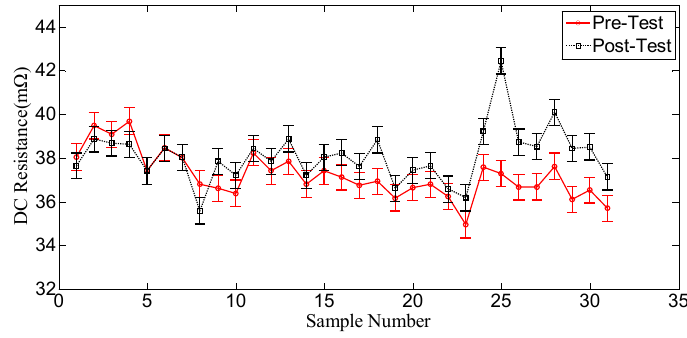
Figure 10. DC resistance distribution before and vibration test.